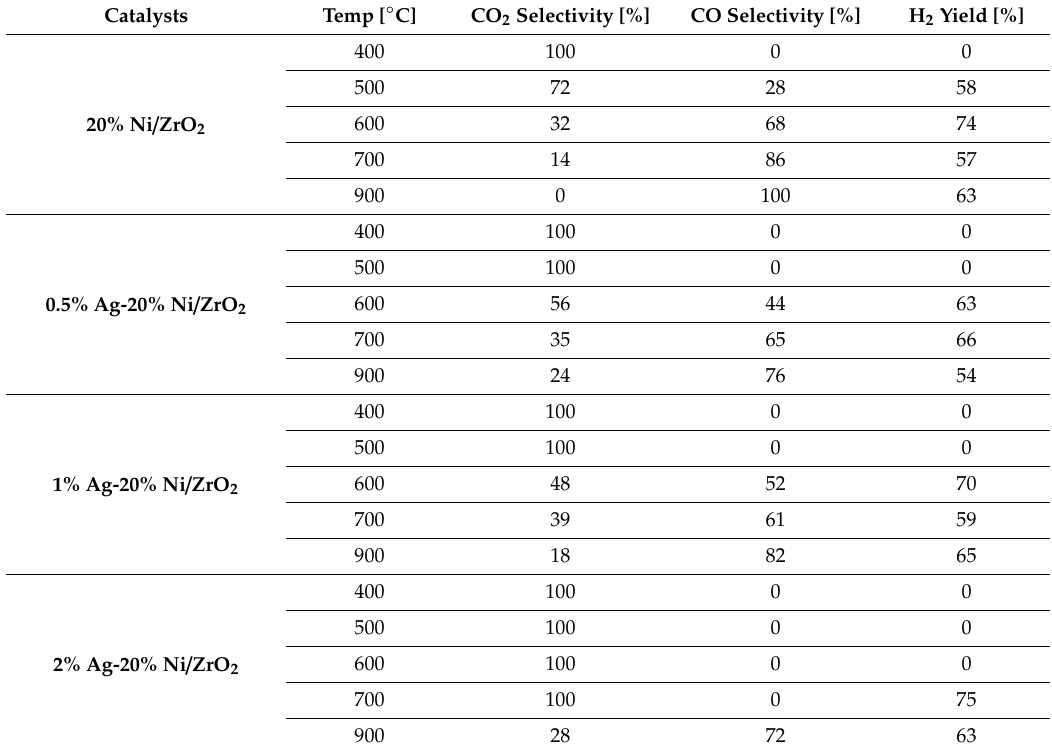
Table 3. The hydrogen yield and selectivity values to CO and CO 2 obtained in the oxy-steam reforming of LNG process over mono- and bimetallic supported